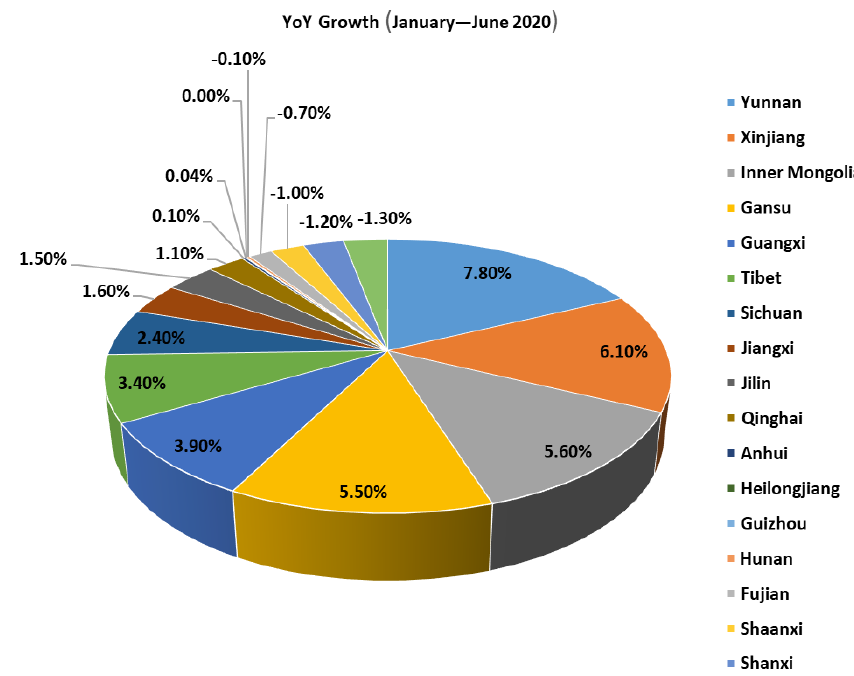
Figure 12. Electricity consumption by region in 2020 in terms of YoY growth. Table 5. Based on the YoY growth in electricity consumption from January to June 2020.